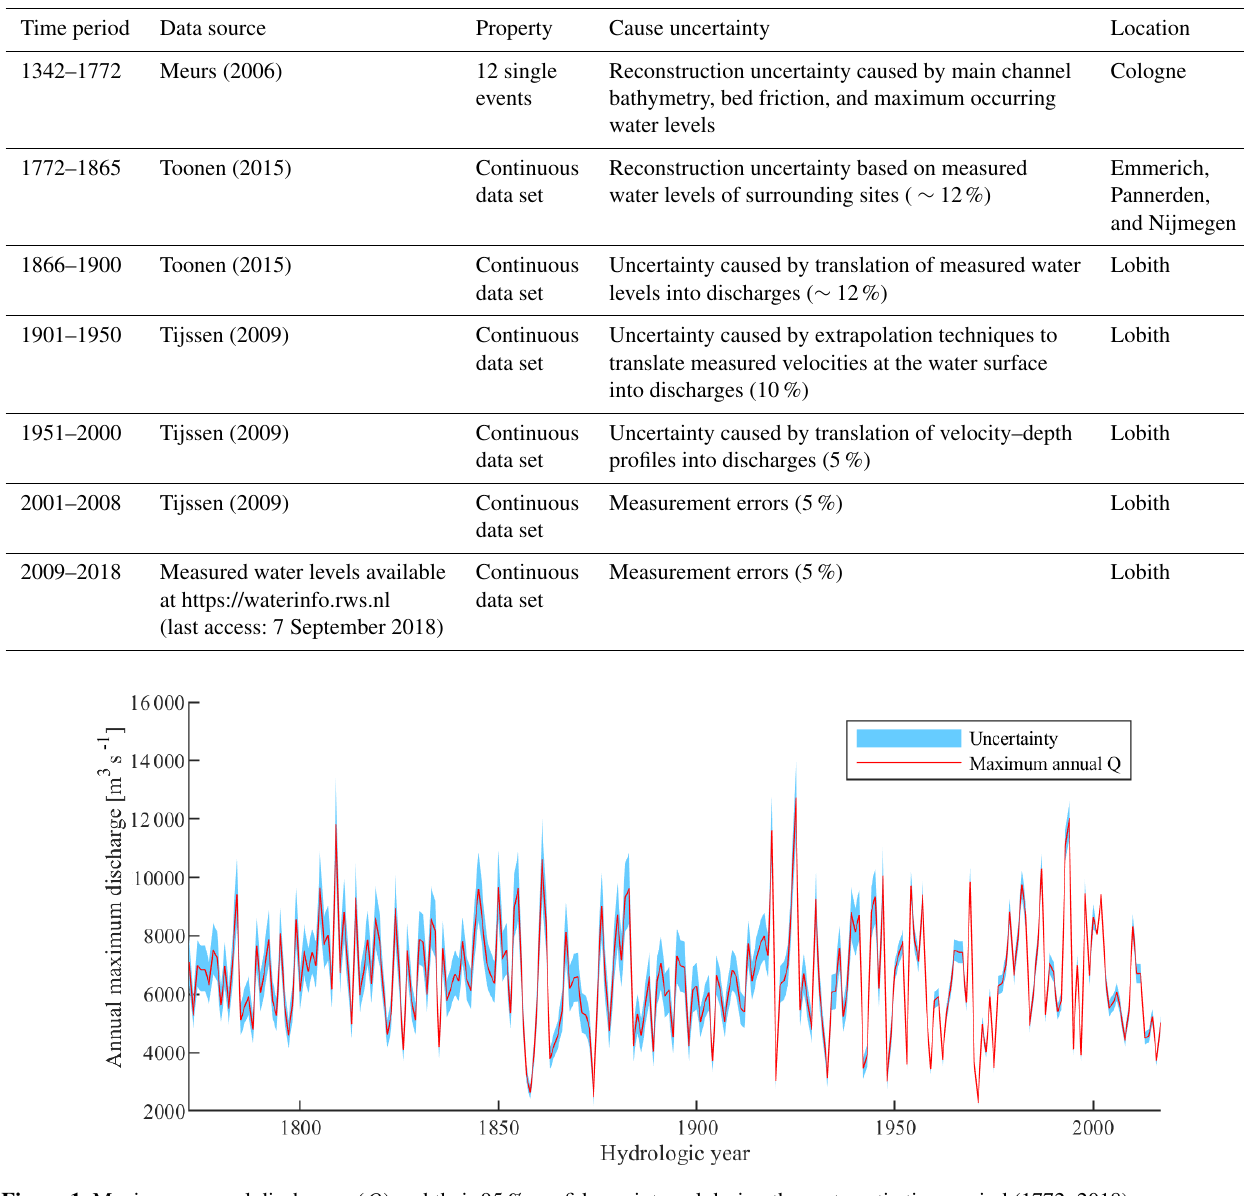
joining in between (Toonen, 2015). This makes the recon- structed discharges at Cologne applicable to predict corre- sponding discharges at Lobith. The model used to perform the hydraulic calculations is described in Sect. 2.3.1. The maximum discharges at Lobith of the 12 historic flood events are given in Sect.